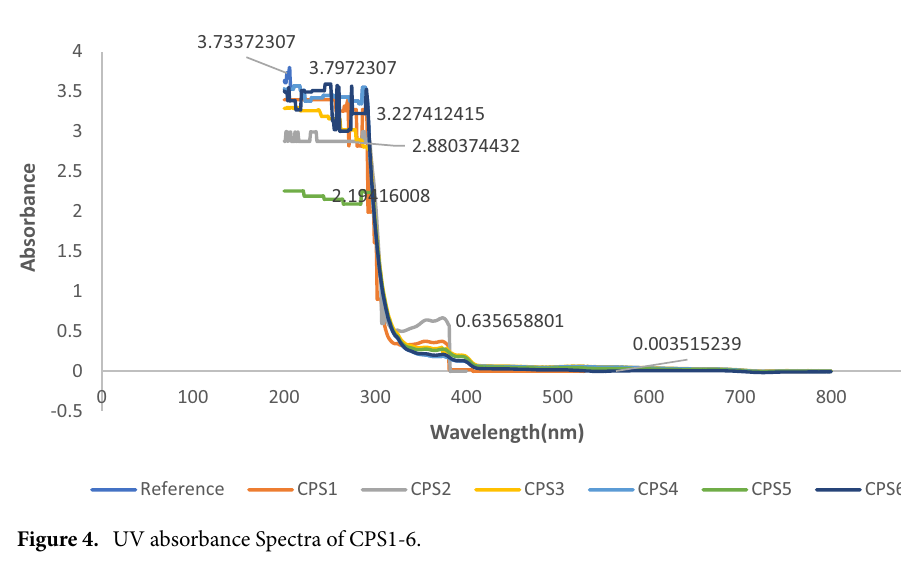
Figure 4. UV absorbance Spectra of CPS1-6.